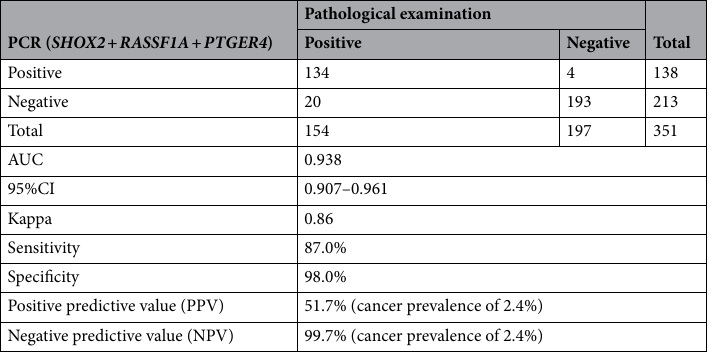
Table 2. The consistency of RT-PCR and pathological examination in detecting aberrant methylation of the SHOX2 , RASSF1A , and PTGER4 gene. SHOX2 Short stature homeobox 2 gene, RASSF1A Ras association domain family 1A gene, PTGER4 Prostaglandin E receptor 4 gene, AUC Area under the curve.